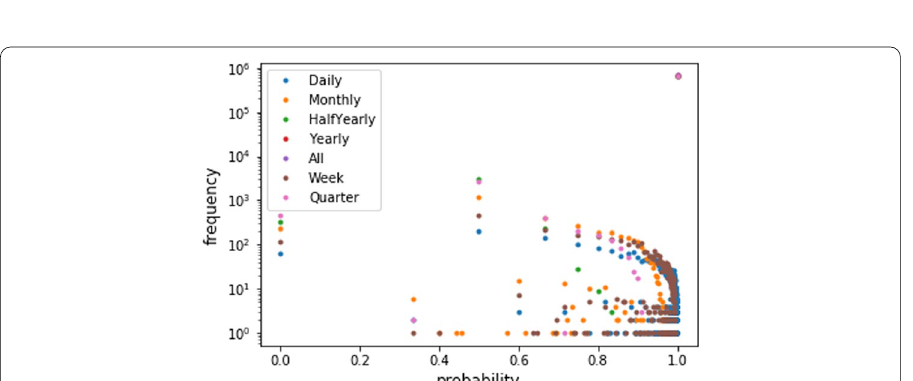
Fig. 14 Number of accounts with certain probability for being benign at different T g s on a semi-log